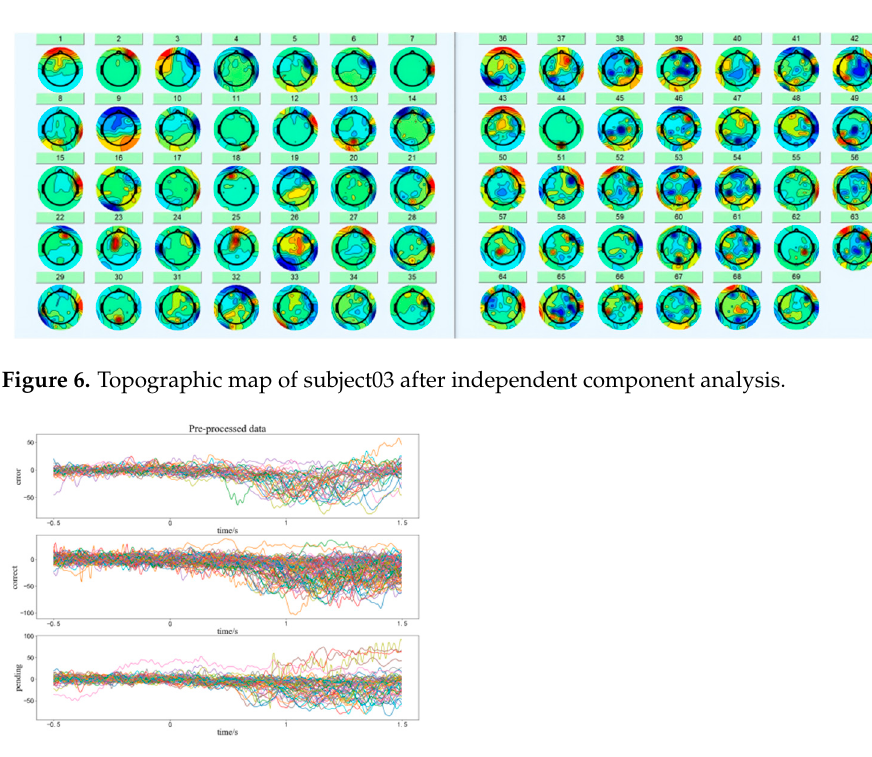
Figure 7. Processed execution waveform segment data of CBz of the subjcet03.